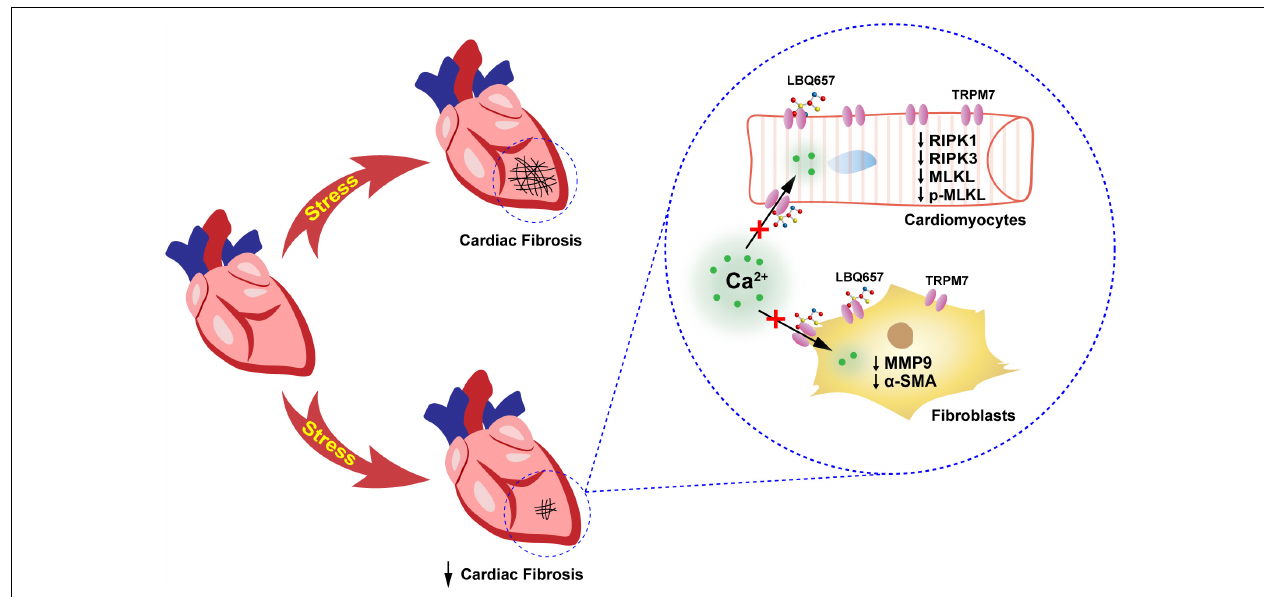
FIGURE 5 | Schematic showing that sacubitril ameliorates cardiac fibrosis through inhibiting TRPM7-mediated Ca 2 + influx in cardiac fibroblasts and cardiomyocytes. This study demonstrated that sacubitril metabolite LBQ657 could relieve the fibrotic response of fibroblasts and reduce cardiomyocyte PCD by blocking TRPM7 channel, thereby ameliorating cardiac